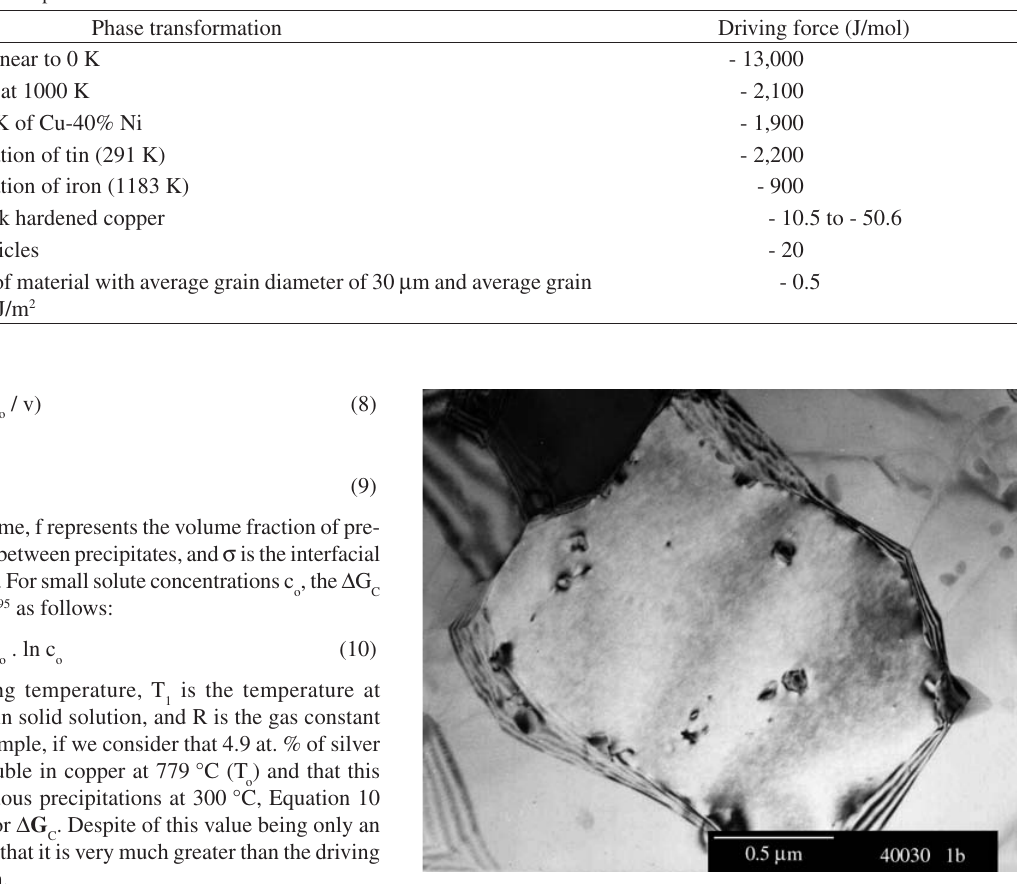
Figure 11. Transmission electron micrograph showing the interaction between intermetallic particles and migrating boundaries during recrystallization of an aluminum alloy 97 .